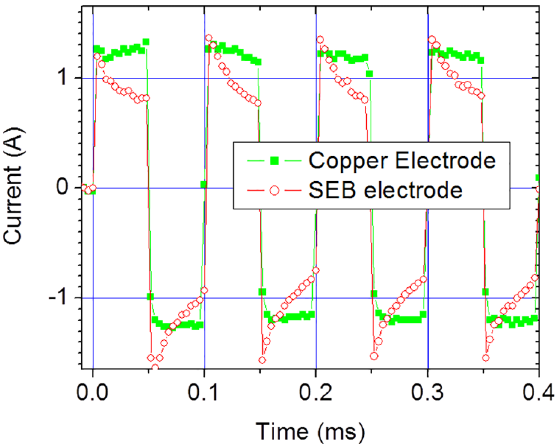
Figure 5. The electrical response of an electrical lysis chamber. A n e l e c t r i c a l l y s i s c h a m b e r , w i t h d i m e n s i o n s 28 mm(L) 6 6.4 mm(W) 6 0.1 mm(H), was filled with 0.25 mM NaCl solution and a fast rising step voltage with an amplitude of 4 and 95 volts was applied to the surface enhanced blocking electrodes. The response at the lower applied voltage was fitted to the models proposed by Bazant et al. [14] and Beunis et al. [19].